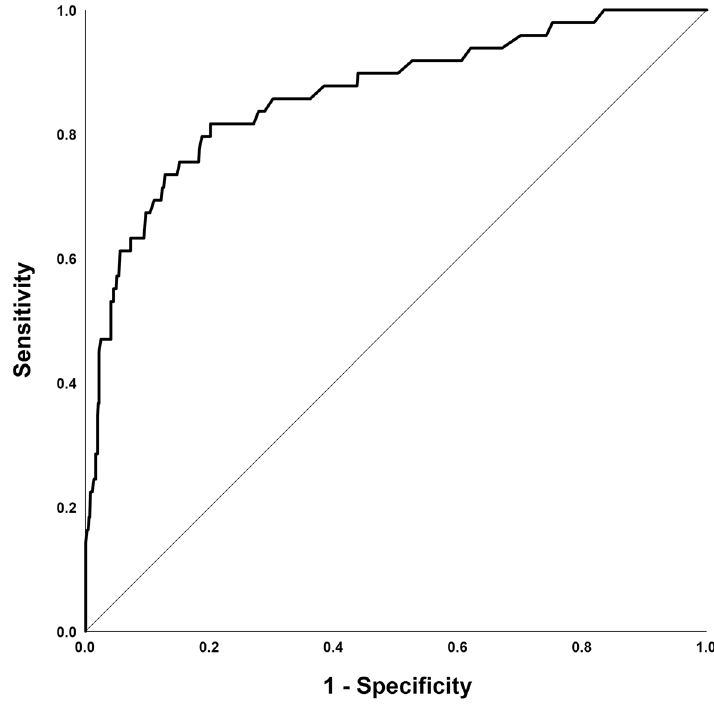
Figure 3. The performance of the nomogram in the validation set was measured using the area under the receiver operating characteristic curve (AUC). AUC of the validation set: 0.866 (95% confidence interval, 0.799 to 0.934).